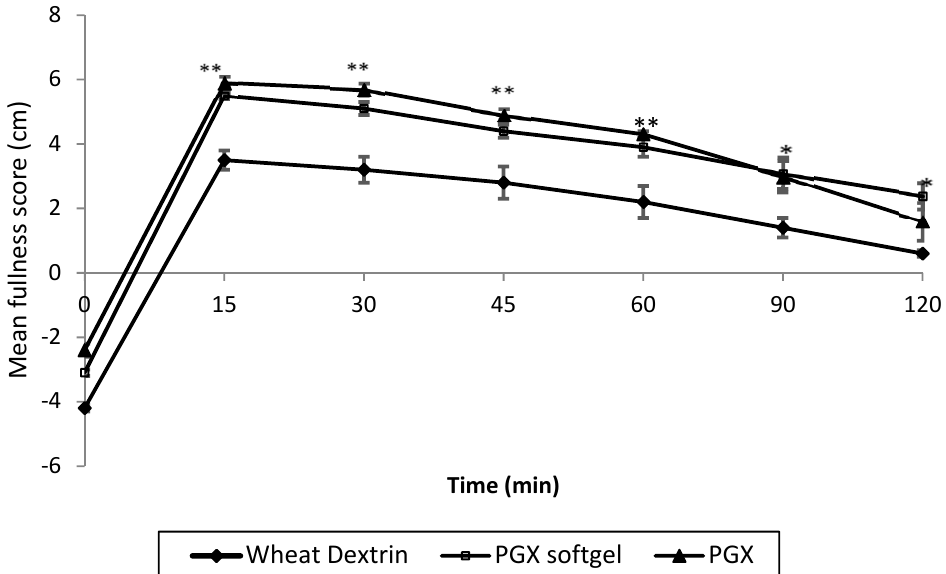
Figure 2. Comparison of self ‐ reported fullness scores (mean ± standard error of mean, SEM) from labelled magnitude scale (LMS) for WD with PGX softgel and PGX (granules). ** fullness score for PGX and PGX softgel were significantly different ( p < 0.01) to WD. * Only PGX softgel was significantly different to WD ( p < 0.01).